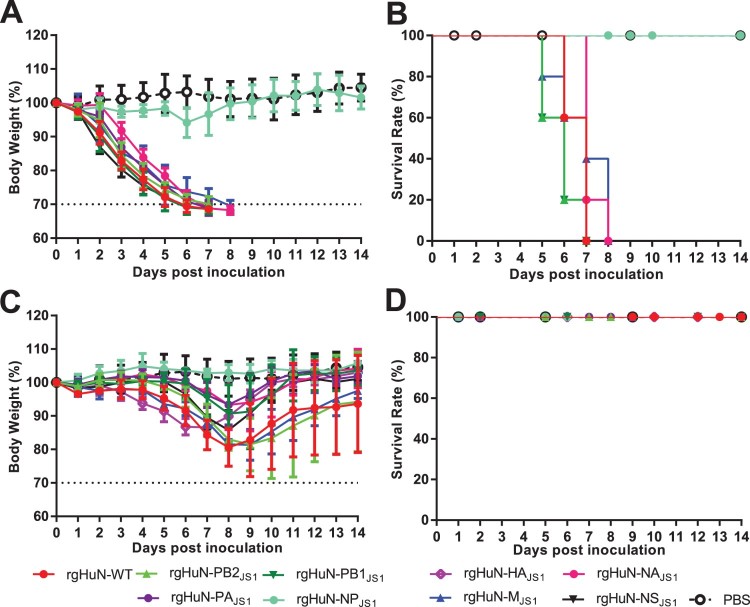
Weight changes and survival rates of mice infected with HuN reassortant viruses. The pathogenicity of reassortants was evaluated by inoculating groups of mice (n = 5 per group) with 106 TCID50 (A, B) or 104 TCID50 (C, D) of virus in 50 μl of PBS or with PBS only (control). Bodyweight loss (A, C) and death (B, D) were monitored during the 14-day observation period after inoculation. rgHuN-WT, rescued wild-type HuN virus; rgHuN-PB2JS1, rescued HuN virus carrying the PB2 gene from JS1 virus; rHuN-PB1JS1, rescued HuN virus carrying the PB1 gene from JS1 virus; rgHuN-PAJS1, rescued HuN virus carrying the PA gene from JS1 virus; rgHuN-NPJS1, rescued HuN virus carrying the NP gene from JS1 virus; rgHuN-HAJS1, rescued HuN virus carrying the HA gene from JS1 virus; rgHuN-NAJS1, rescued HuN virus carrying the NA gene from JS1 virus; rgHuN-MJS1, rescued HuN virus carrying the M gene from JS1 virus; rgHuN-NSJS1, rescued HuN virus carrying the NS gene from JS1 virus.